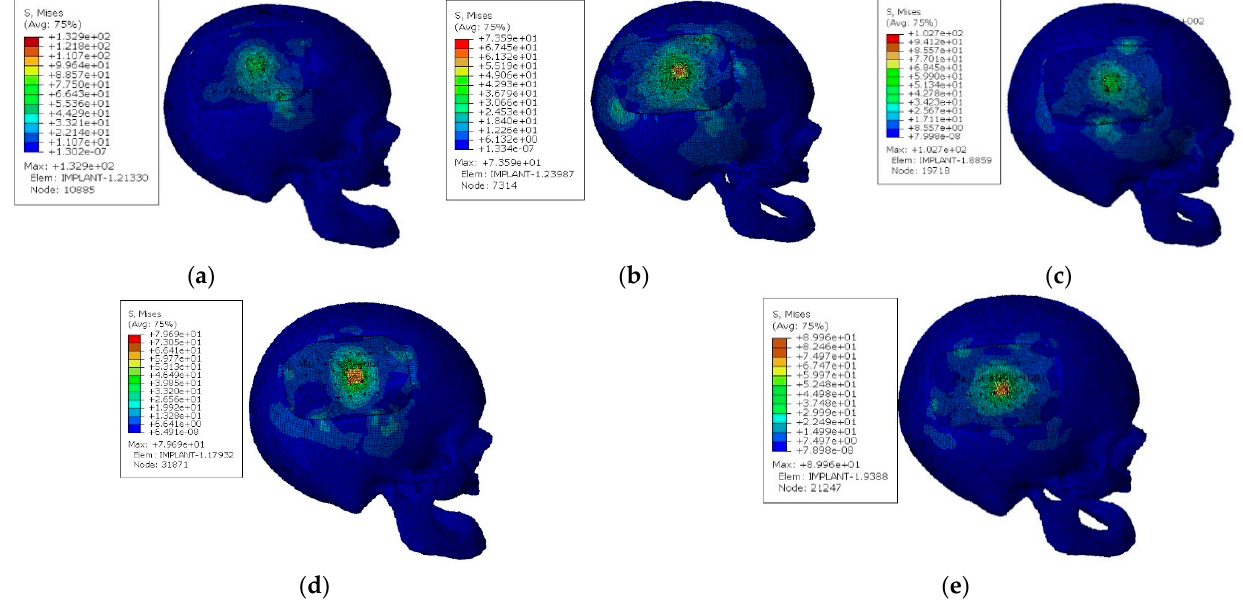
Figure 4. Von Mises stress fields for the models with different screws configurations [MPa]: ( a ) con- figuration with five screws; ( b ) configuration with six screws; ( c ) configuration with seven screws; ( d ) configuration with eight screws; ( e ) configuration with nine screws.